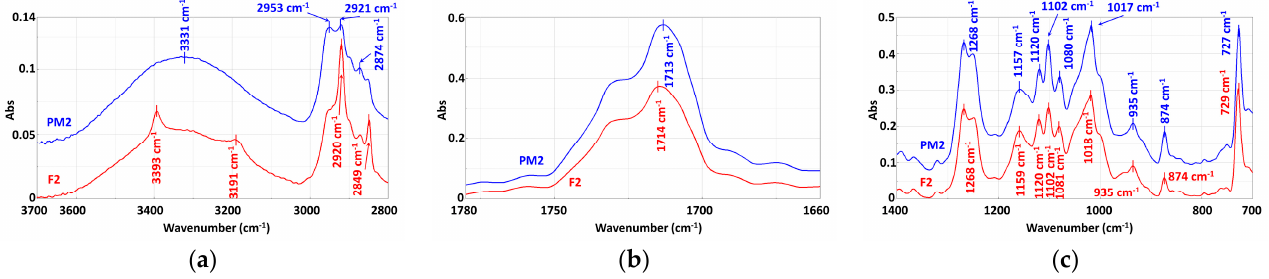
Figure 8. The FTIR spectra of the F2 and PM2 compounds: ( a ) 3700–2800 cm − 1 ; ( b ) 1780–1680 cm − 1 ; ( c ) 1400–700 cm − 1 . ( c ) 1400–700 cm − 1